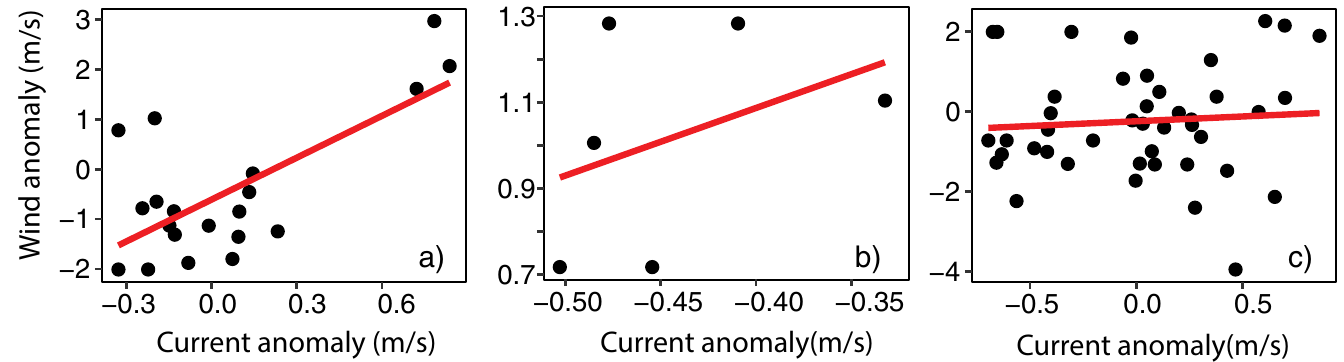
Fig 12. The relationship between wind speed anomaly and current speed anomaly in the Pemba Channel during a) IN, b) NE and c) SE monsoon seasons.